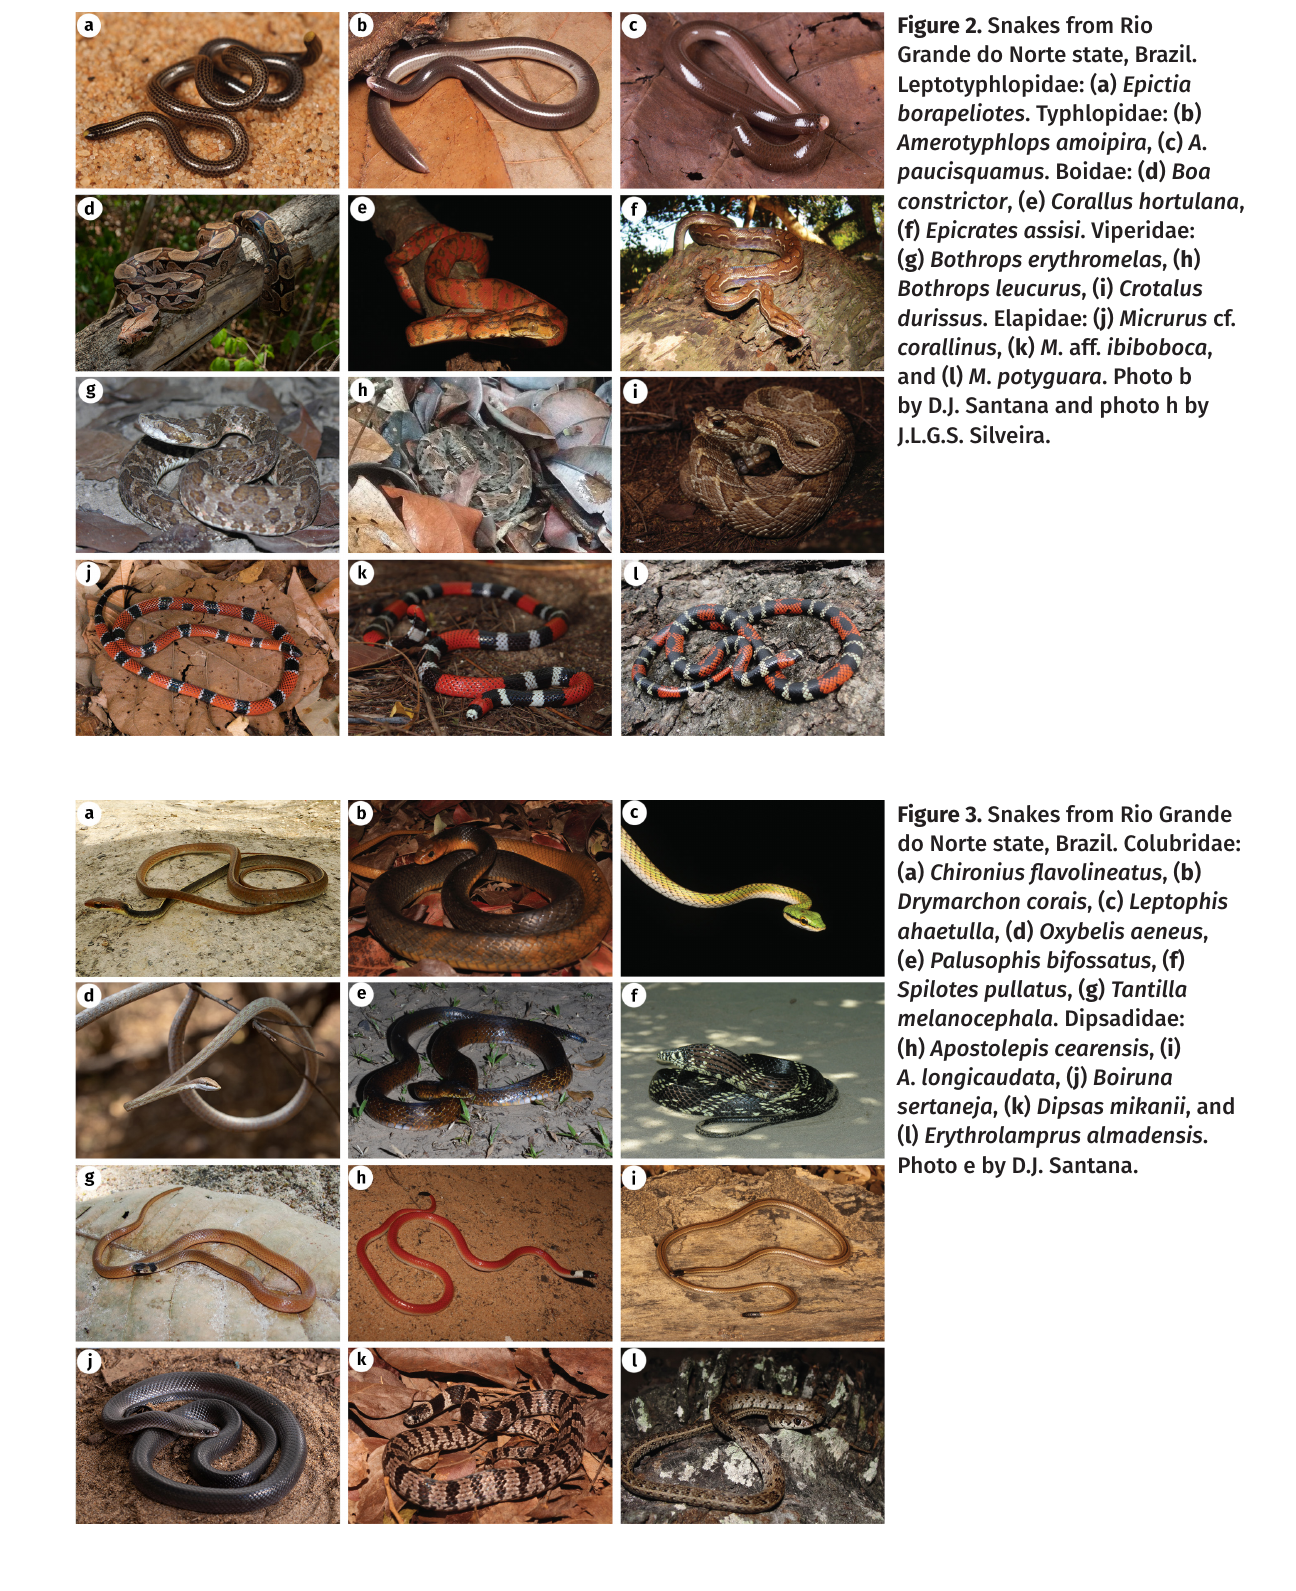
Figure 2. Snakes from Rio Grande do Norte state, Brazil. Leptotyphlopidae: ( a ) Epictia borapeliotes . Typhlopidae: ( b ) Amerotyphlops amoipira , ( c ) A . paucisquamus . Boidae: ( d ) Boa constrictor , ( e ) Corallus hortulana , ( f ) Epicrates assisi . Viperidae: ( g ) Bothrops erythromelas , ( h ) Bothrops leucurus , ( i ) Crotalus durissus . Elapidae: ( j ) Micrurus cf. corallinus , ( k ) M . aff. ibiboboca , and ( l ) M . potyguara . Photo b by D.J. Santana and photo h by J.L.G.S.